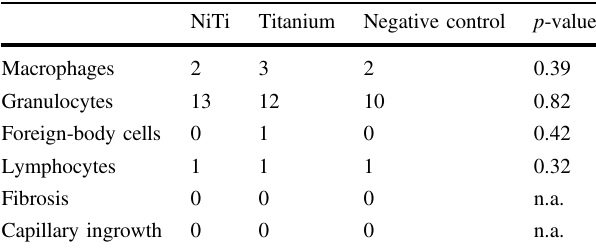
Table 2 Quanti fi cation of histological signs of acute and chronic in fl ammation in the soft tissue adjacent to the